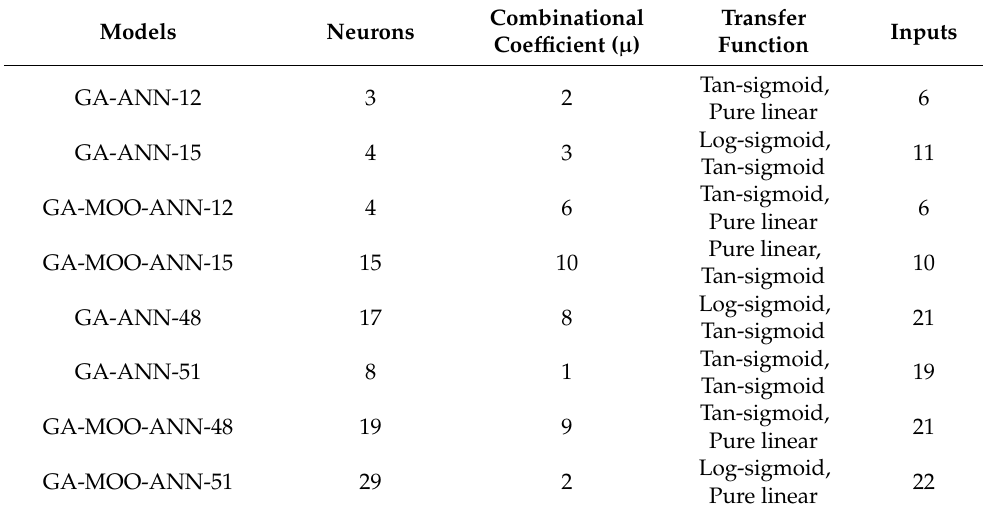
Figure 5. The variation of fitness value of each generation during the learning of the GA-ANN model. Table 5. Optimally selected parameters of GA-MOO-ANN and GA-ANN